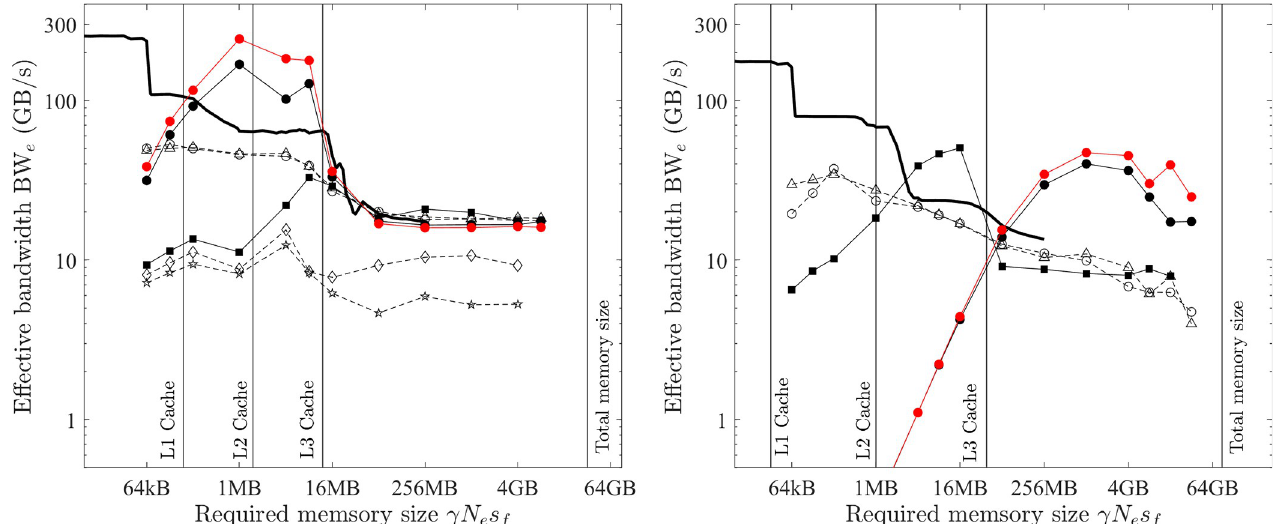
Fig 15. Optimal implementation of HEAT1D on the CPU platform (double precision; solid black line = benchmarked bandwidth; lines + symbols = effective bandwidth; red = COPY1D; black = HEAT1D; filled circles = OpenMP parallel for with the maximal no. of threads, hollow circles = OpenMP parallel for with one thread; hollow triangles = single-thread SIMD; filled squares = XLA with slice and concatenation; hollow diamonds = XLA with convolution; hollow pentagons = XLA with roll). (a) PC. (b) HPC.